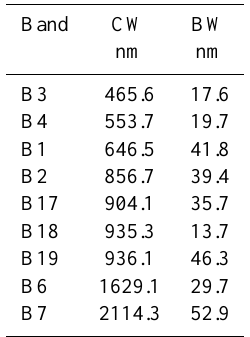
Table 3. MODIS bands used for the comparison, listed for increas- ing wavelength. BW is the bandwidth defined by the 1% points in the L1B in-band RSR. Band